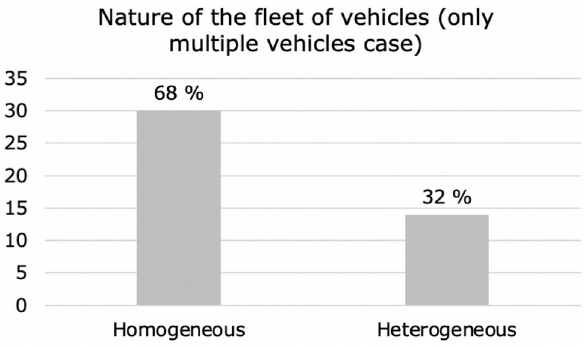
Figure 11. Statistics on supply chain structure: nature of the fleet of vehicles (only multiple vehicles